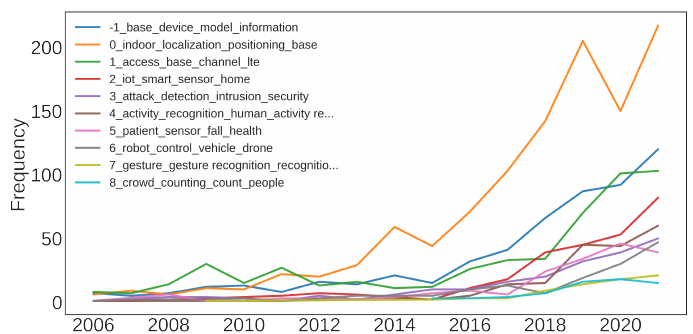
Figure 9. Number of articles published over the years for every